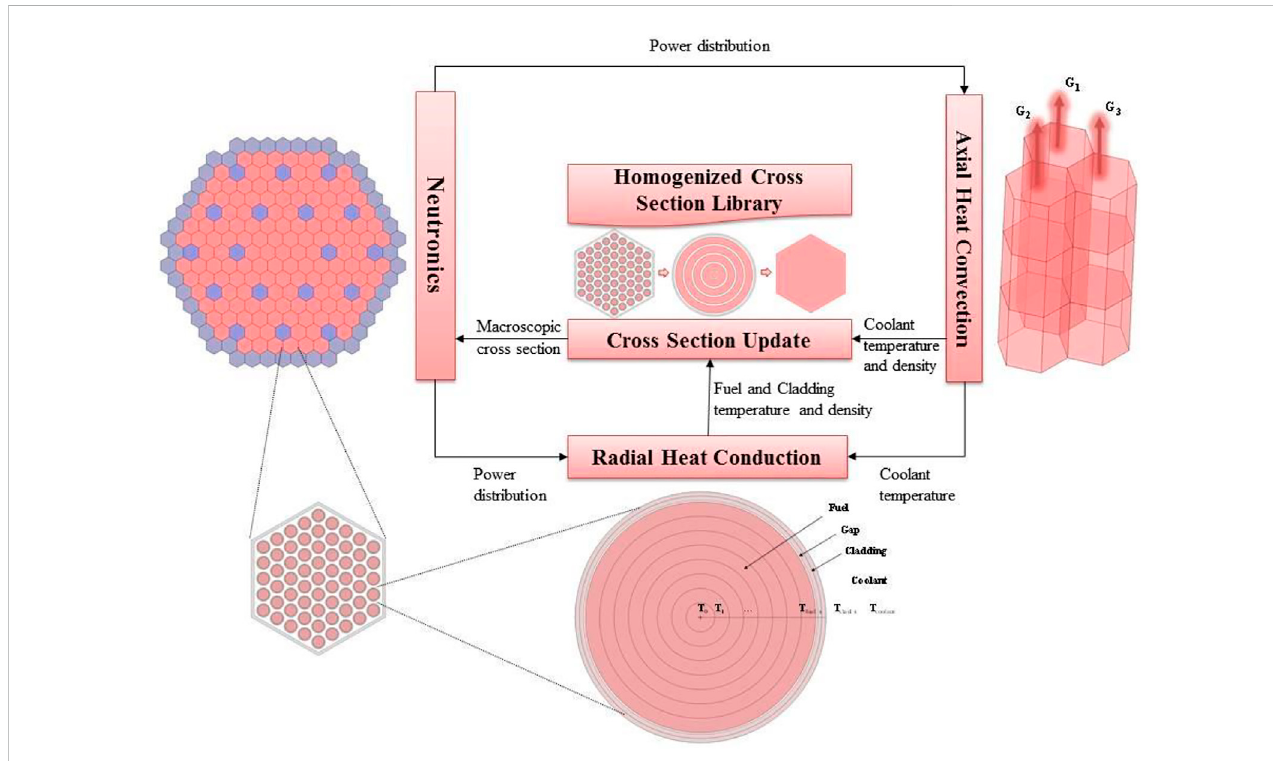
FIGURE 4 NE/TH coupling calculation process.